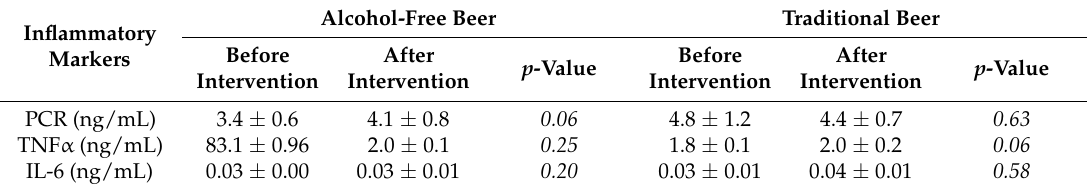
Table 7. Effect of the intervention with alcohol-free and traditional beer on inflammatory markers. Alcohol-Free Beer Traditional Beer Inflammatory Before After Before After Markers p -Value p Intervention Intervention Intervention Intervention